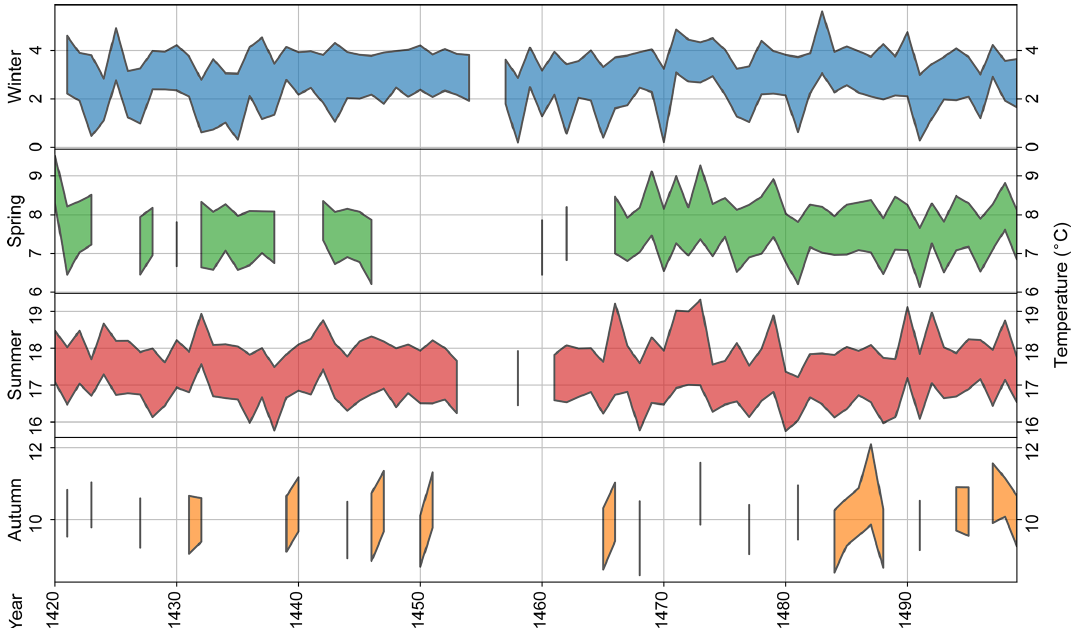
Figure 6. Seasonal mean temperatures in the Burgundian Low Countries from 1420 to 1499CE. Colored areas show mean temperatures ± 1 standard deviation averaged over all members of the ModE-Sim ensemble. They are reconstructed from posterior probability distributions after assimilating regional information from historical